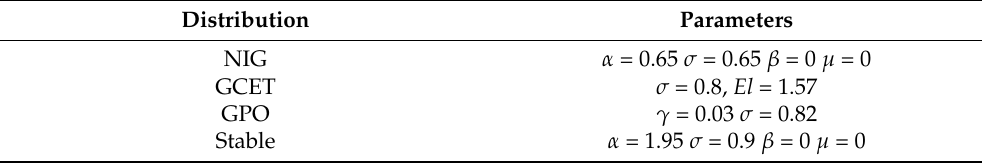
Table 2. Distributions and parameters of the false parametric model for